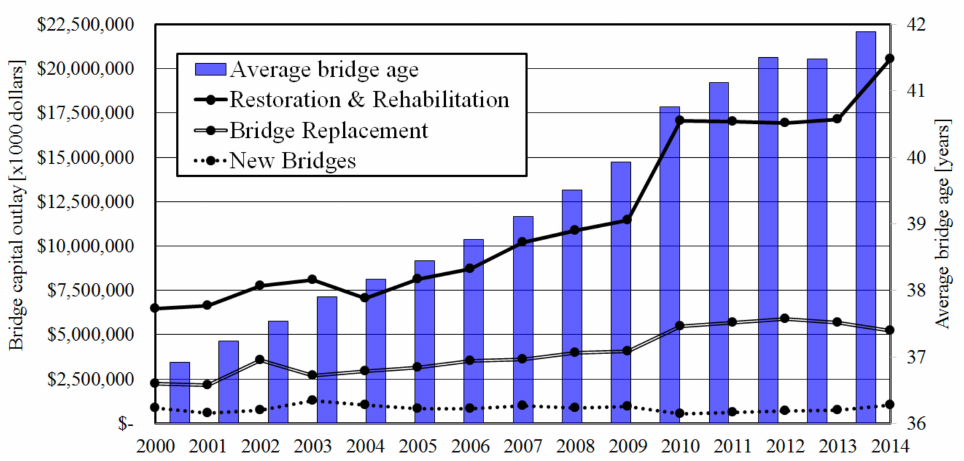
Figure 2. US bridges capital outlay and age (routine maintenance costs not included)